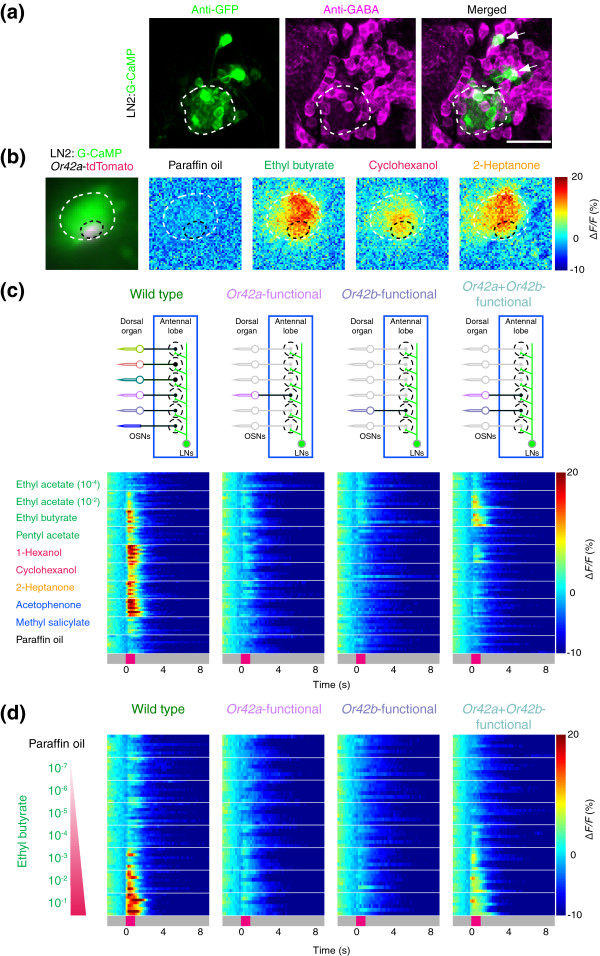
Threshold response properties of larval local interneurons. (a) LN2 cells in the antennal lobe stained to reveal G-CaMP (left; anti-GFP antibody, green) and gamma-aminobutyric acid (middle; anti-GABA, magenta). Arrows in the merged image (right) indicate GABA-positive LN2 neurons. (b) Imaging LN activation at the terminal of the Or42a neuron, as marked by an Or42a-nsyb:tdTomato reporter. The leftmost panel is a merged image of intrinsic fluorescence of G-CaMP (green) and nsyb::tdTomato (magenta). The boundary of the antennal lobe is marked with a white dashed line and the Or42a glomerulus with a black dashed line. The other three panels show antennal lobe calcium responses to paraffin oil (solvent) and three odorants (10-2 dilution) taken 400 ms after stimulus onset, represented as ΔF/F (%) (scale at right). (c) Top panel: schematic for measuring functional activation of LN2 neurons in the antennal lobe (blue boxes) of wild-type, Or42a-, Or42b-, and Or42a+Or42b-functional larvae. Bottom panel: responses of LN2 neurons in larvae of indicated genotype to eight odorants (10-2 dilution except as indicated) and paraffin oil (solvent) represented as false color-coded time traces (%ΔF/F; scale at bottom right). Traces from n = 6–9 animals per stimulus are stacked. (d) Responses in LNs in larvae of indicated genotype to an ethyl butyrate concentration series and paraffin oil (solvent) represented as ΔF/F (%) (scale at right). Traces from n = 6–8 animals per genotype and stimulus are stacked.